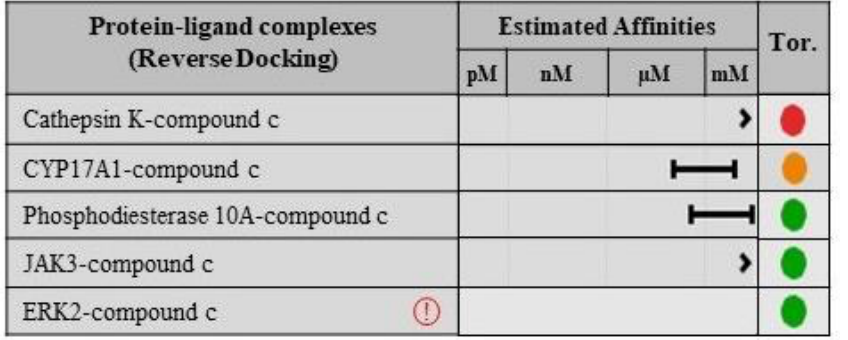
Figure 11. The estimated affinities of compound c with the predicted macromolecular targets obtained from molecular docking. The colored circles are depicting the torsion quality of the compound c upon docking with respective macromolecule where green color depicts no torsion, orange color shows bad torsion and red color represents worse torsion.